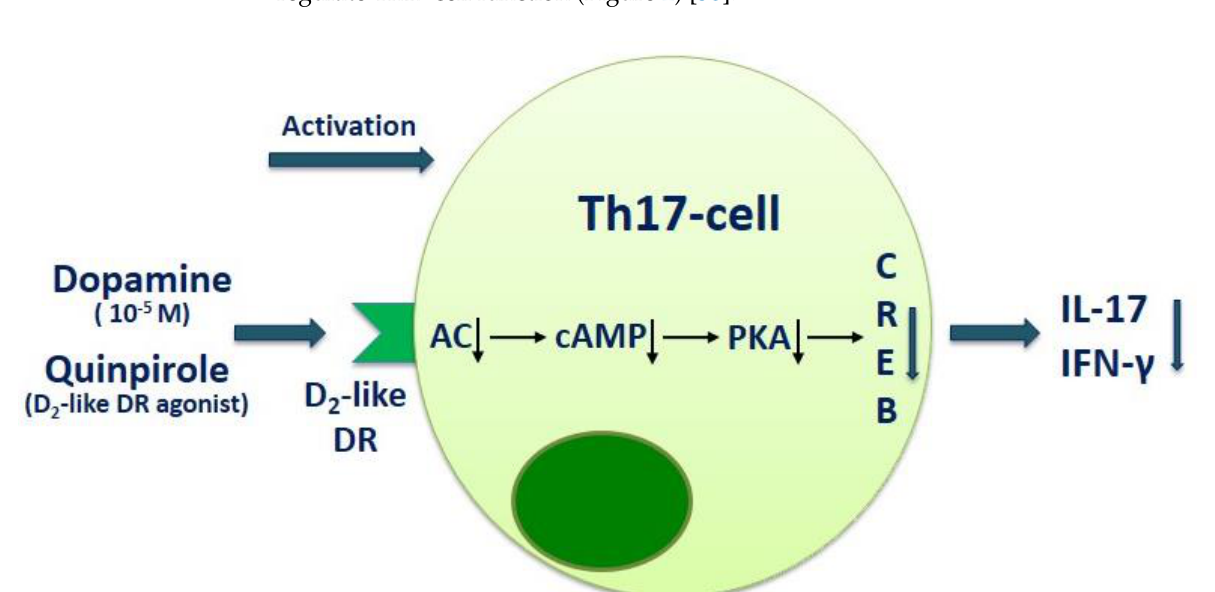
Figure 2. The role of dopamine and D 2 -like dopaminergic receptor in modulation of Th17 cell function. D 2 -like DR—D 2 - like dopaminergic receptor; CA—adenylyl cyclase; cAMP—cyclic adenosine monophosphate; PKA—protein kinase A; CREB—cAMP response element-binding protein.